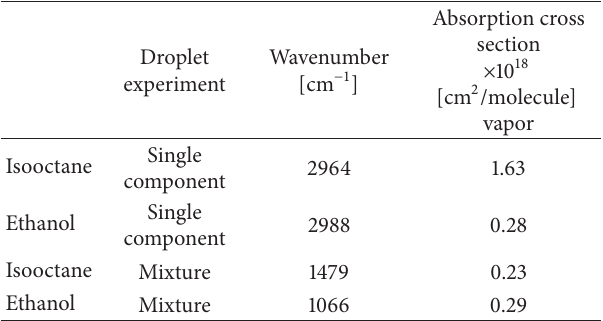
Table 1: Selected wavenumber used to track species concentration in absorption